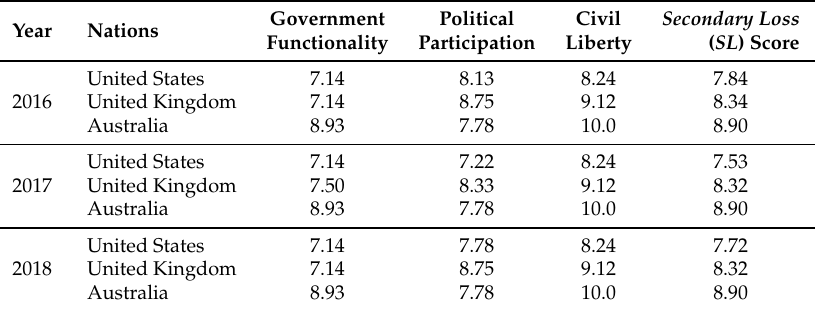
Figure 6. The Primary Loss ( PL ) score is based on the “Breach Level Index” data from 2016 to 2018, and the score is expressed as 0 to 10, but the risk for average data leakage is decreasing. Table 5. The Secondary Loss ( SL ) Score is the average of government functionality, civil liberties, and political